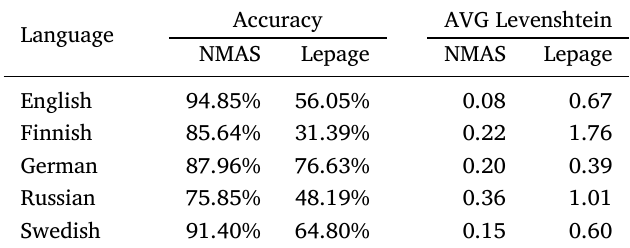
Table 4: Prediction accuracy and average Levenshtein distance of the proposed model (NMAS) trained using one language. Baseline: Lepage